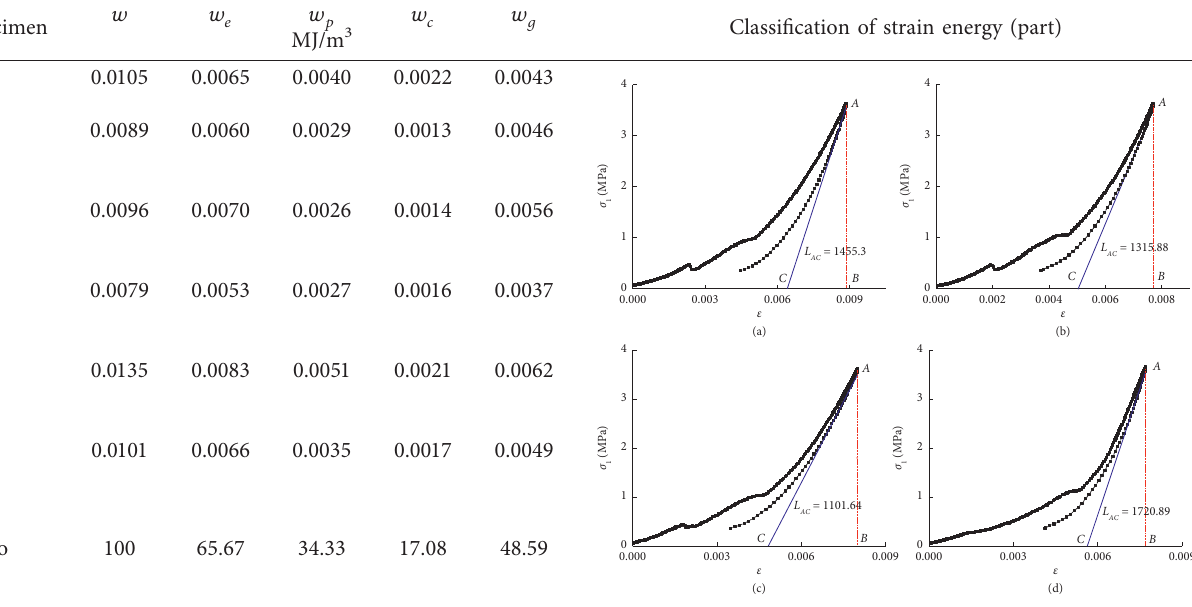
Table 3: Strain energy of coal samples from coal mine C.